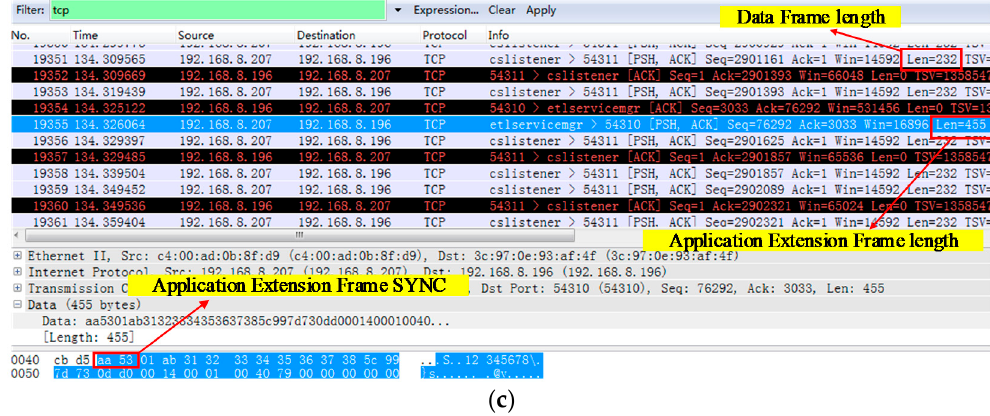
Figure 11. Extended protocol running result. ( a ) Communication data traffic when application extension frames delivery period is 2 s; ( b ) communication data traffic when application extension frames delivery period is 5 s; ( c ) application extension frames and data frames in extended protocol.